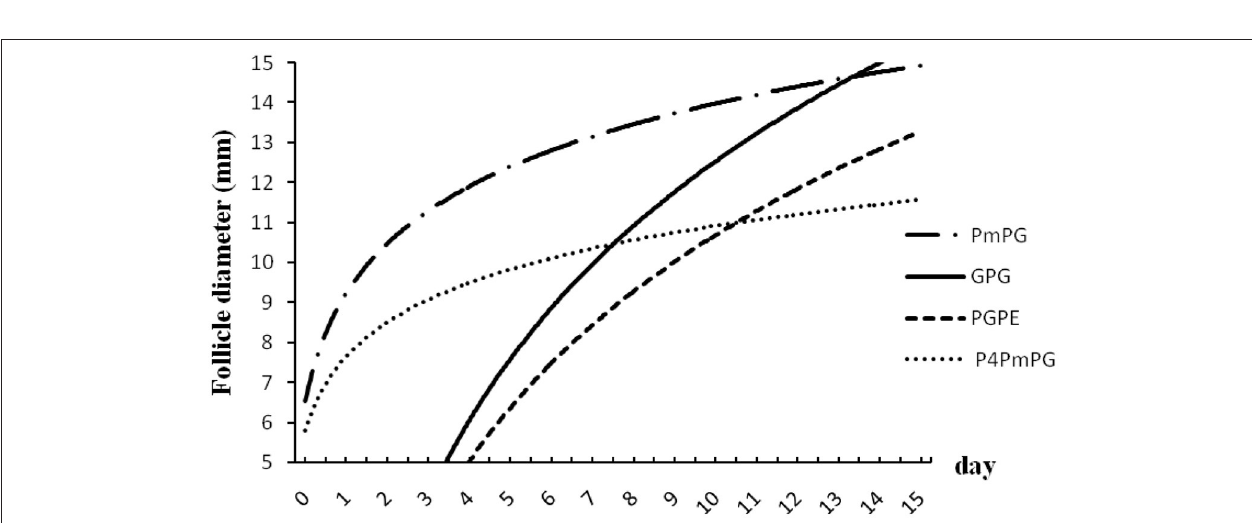
FIGURE 3 | Follicular dynamics in crossbred buffaloes subjected to different TAI synchronized protocol (PmPG, GPG, PGPE, and P4PmPG). Values in both X- and Y-coordinates were transformed in logarithm to compare the different